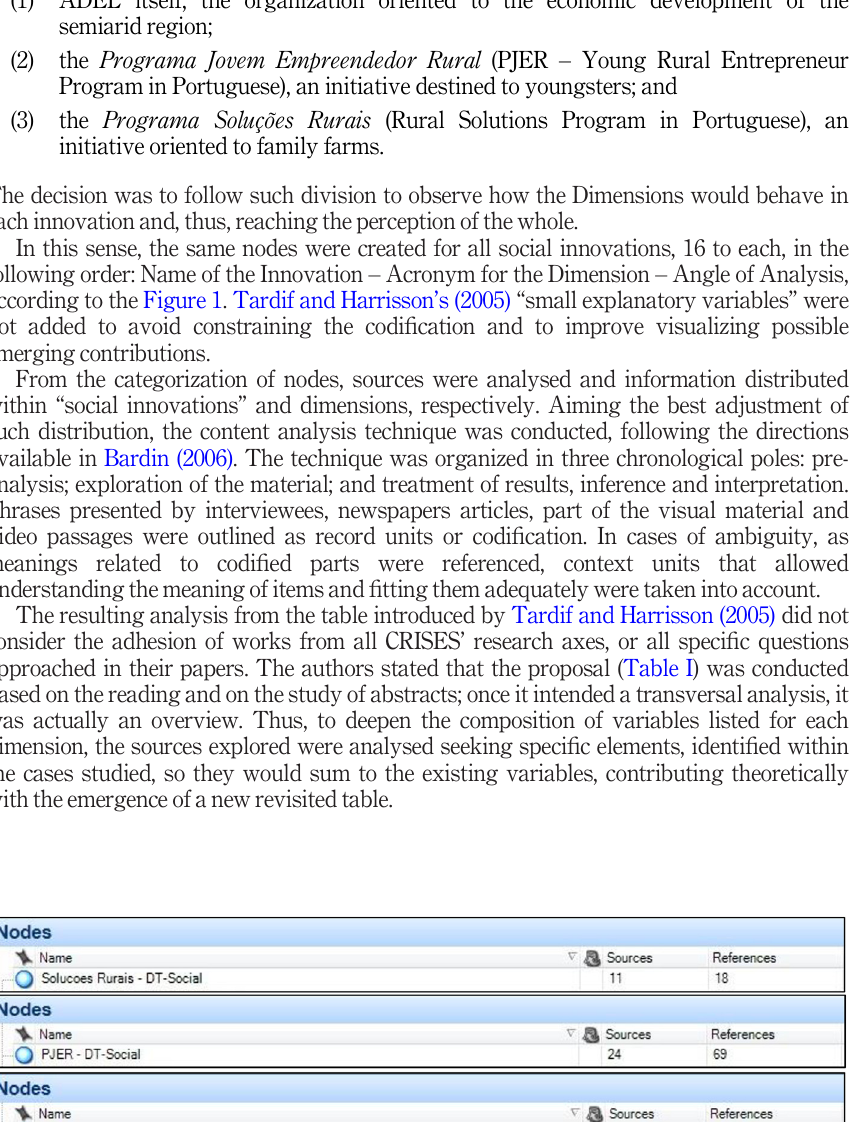
Figure 1. Research nodes categorization